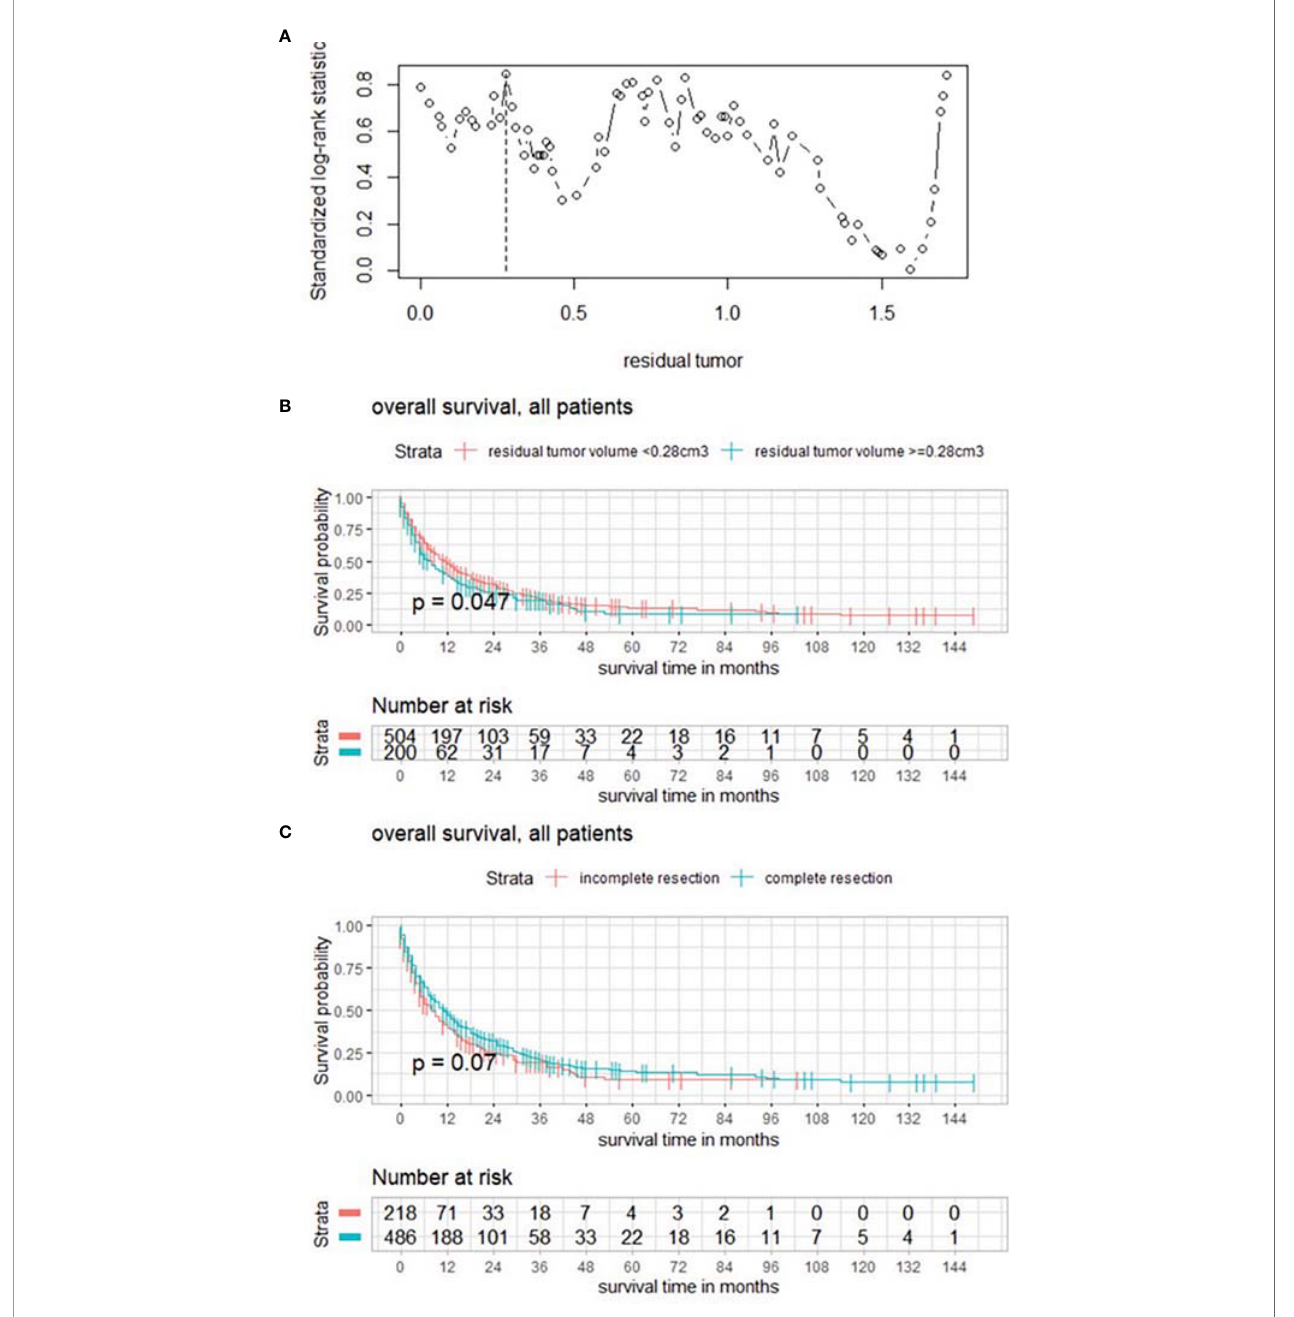
FIGURE 2 | (A) Maximally selected log rank statistics displaying the cutoff of postoperative tumor volume of the targeted BM. (B) Functions of overall survival in all patients for these subgroups demonstrating signi fi cantly divergent survival curves. (C) Functions of overall survival in subgroups of complete/incomplete cytoreduction, regardless of number of